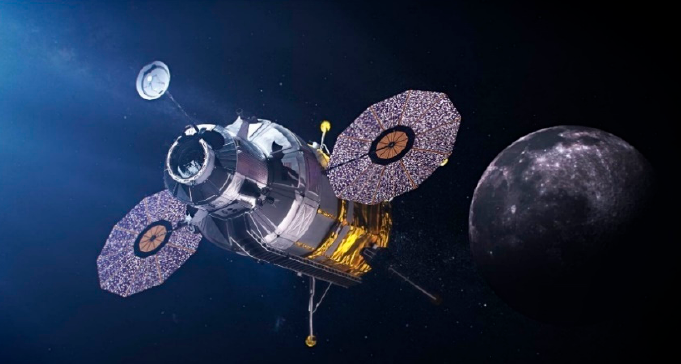
Figure 1. Lunar lander concept sought for the Artemis program, image courtesy NASA [2], image use in accordance with NASA image use policy. Reprinted/adapted with permission from Ref. [3]. NASA”.